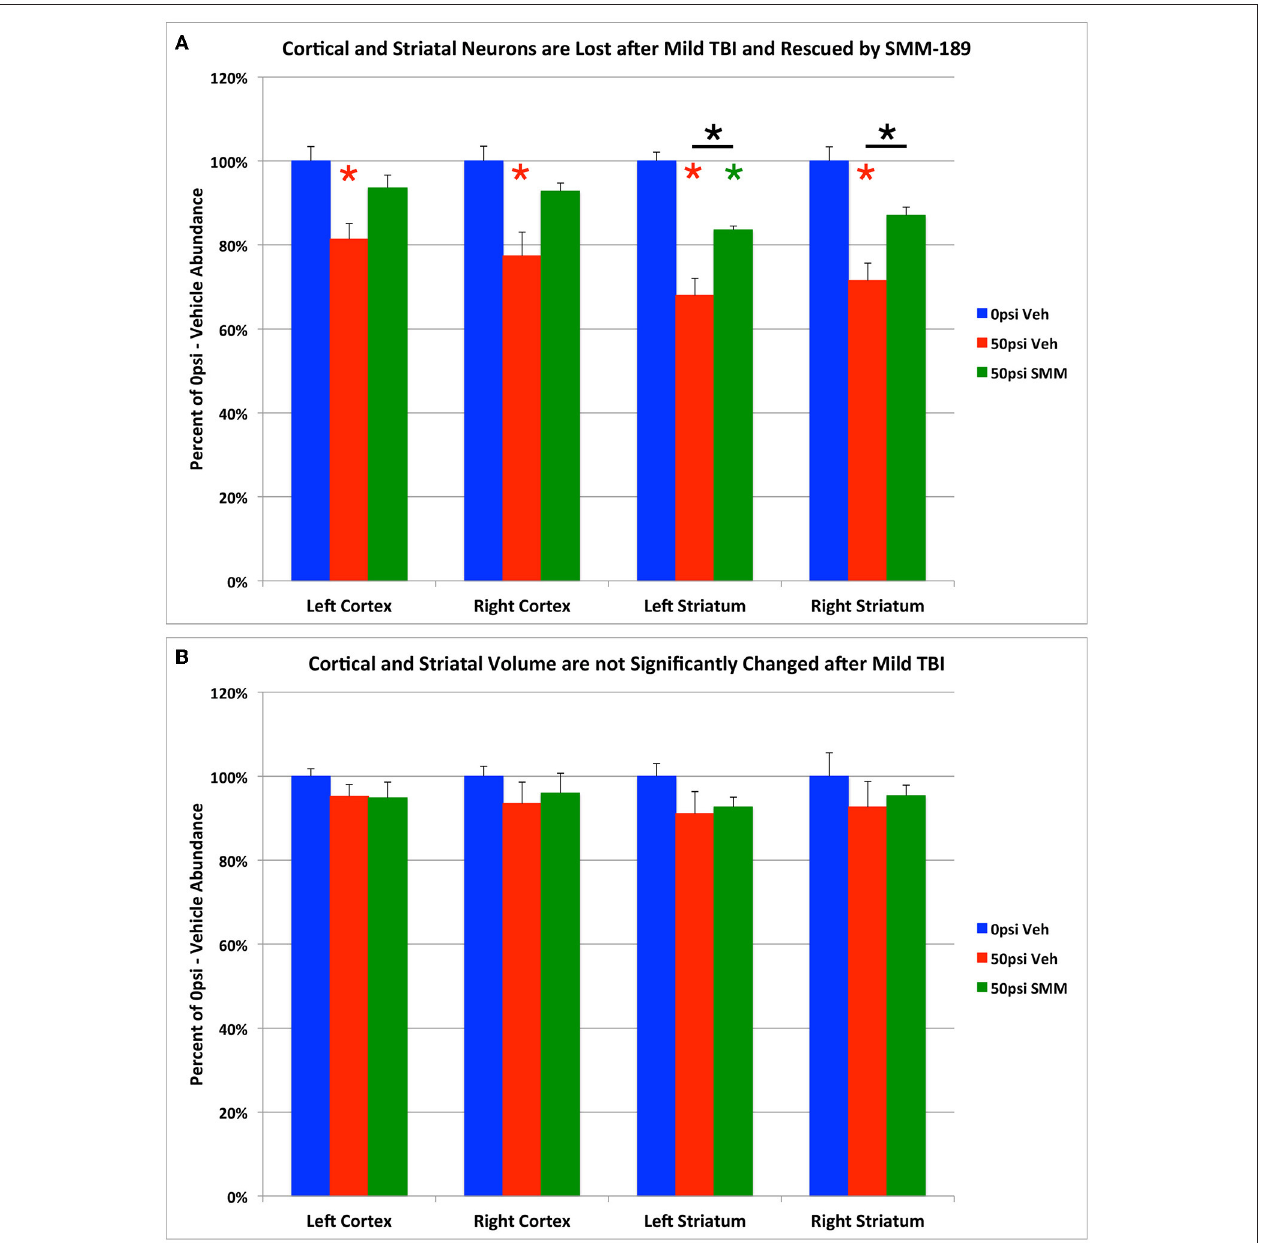
FIGURE 4 | Graphs showing the effect of TBI and SMM-189 on NeuN + neurons (A) and on volumes (B) in cerebral cortex and striatum. Stereological counts (A) revealed bilateral neuron loss in the 50-psi vehicle-treated cortex and striatum, and significant rescue after SMM-189 treatment. Red asterisks indicate a significant difference between vehicle-treated 50-psi mice and vehicle-treated 0-psi mice. Green asterisks indicate a significant difference between SMM-189 and vehicle-treated 0-psi mice. Asterisks above bars spanning the SMM-189 and vehicle-treated 50-psi mice columns indicate a significant difference between these two conditions. No significant volume loss is evident in the 50-psi vehicle-treated cortex or striatum (B) , compared to 0-psi vehicle-treated cortex and striatum, although a trend toward reduction is seen.